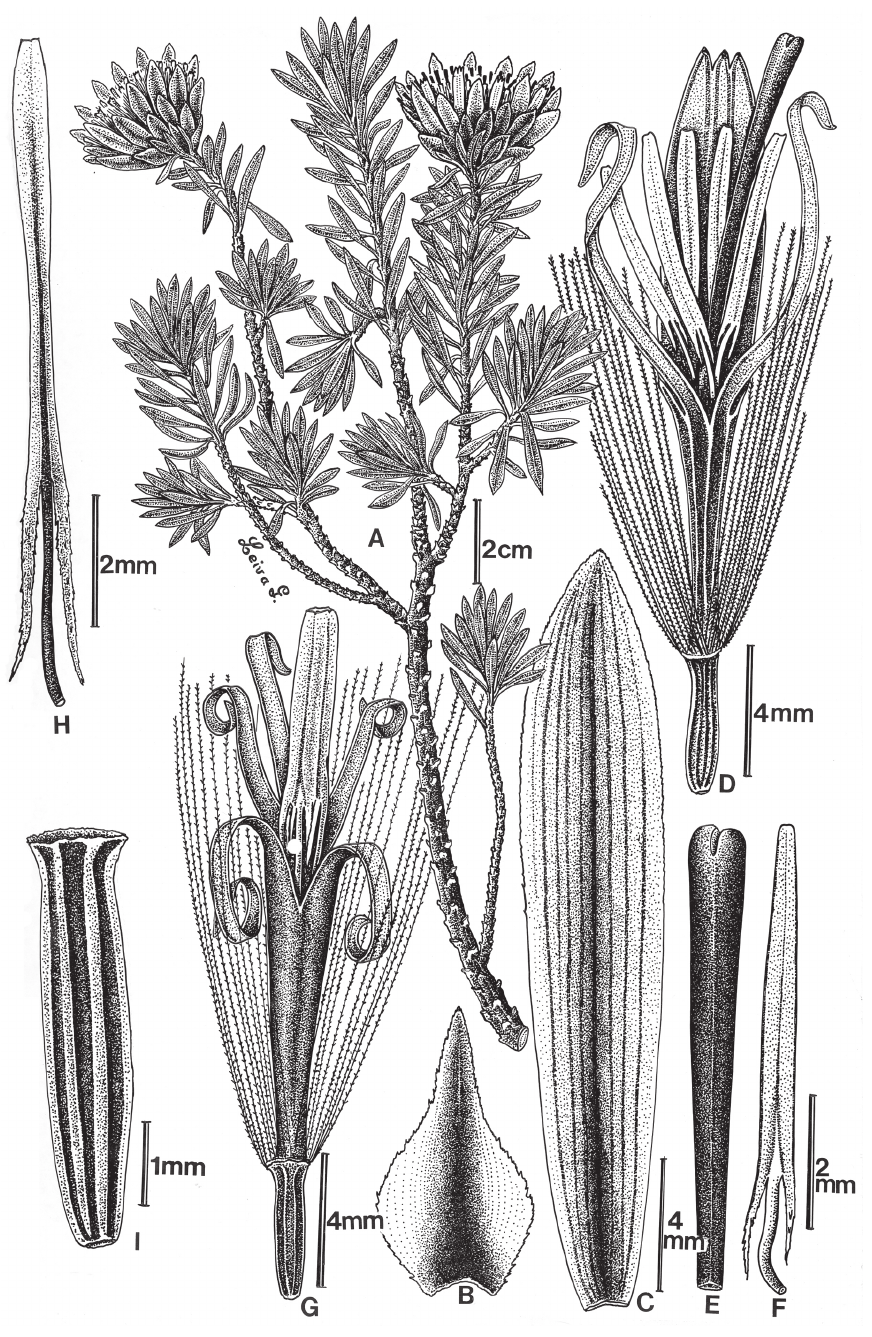
Figure 2. Plazia robinsonii M.O. Dillon & Sagást. (drawn from A. L ó pez M. & A. Sag á stegui A. 8123 ). A Flowering branch B External phyllary C Internal phyllary D Ligulate floret e Terminal portion of the style of ligulate florets F Stamen from ligulate floret G Disc floret h Stamen from disc floret I